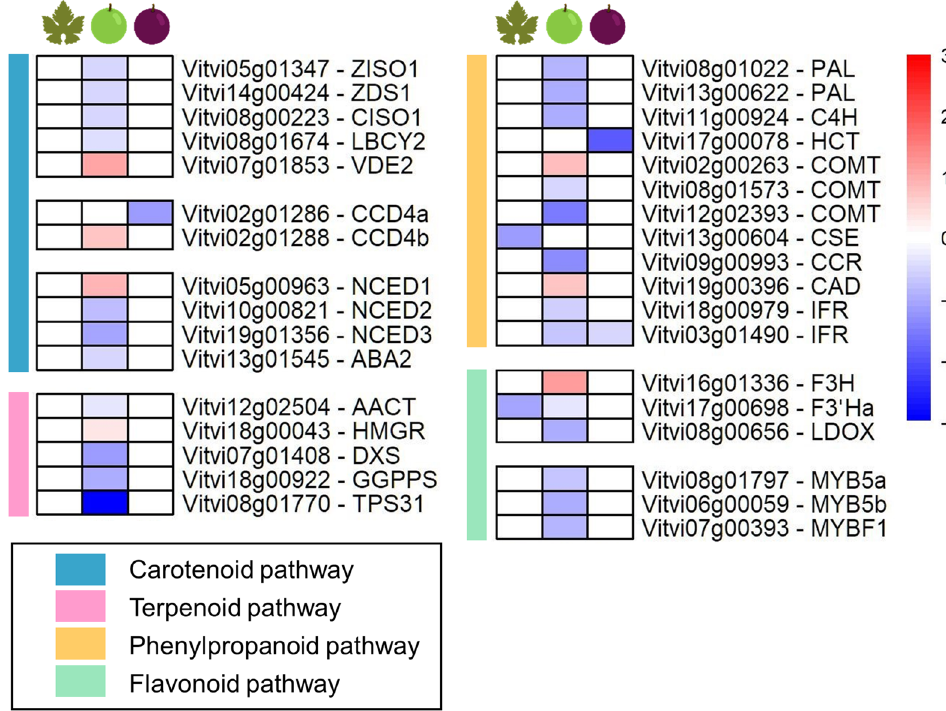
Figure 7. Secondary metabolites genes modulated by the ozonated water treatment in leaves (left column), berries at the beginning of ripening (middle column) and berries in mid-ripening (right column) are represented in heatmaps as log 2 FC(OW/C). Red and blue colours indicate up- or down-regulation, respectively. The coloured sidebar on the left displays the class of